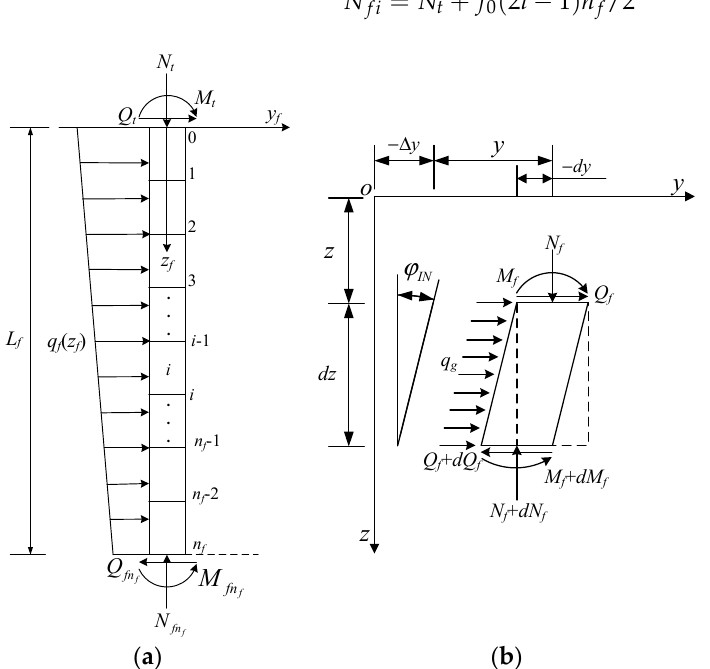
Figure 4. Discretization of free segment and element analysis for a segment. ( a ) Discretization of free segment. ( b ) Element analysis for a segment.